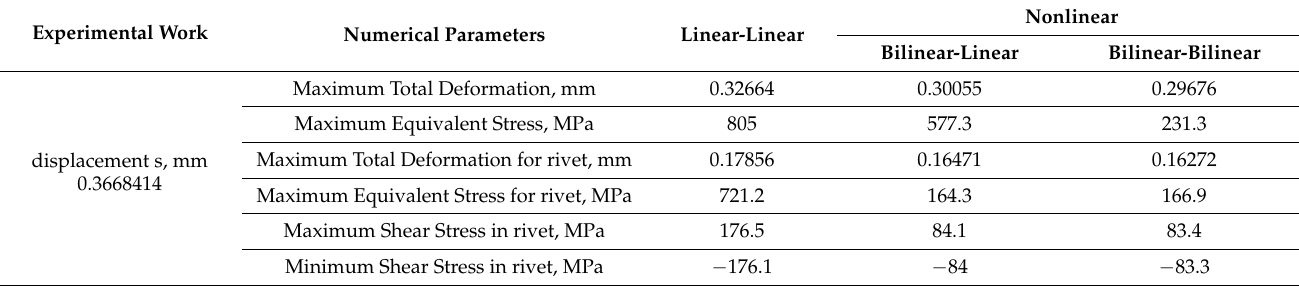
Table A5. Experimental and numerical results for the load force F = 900